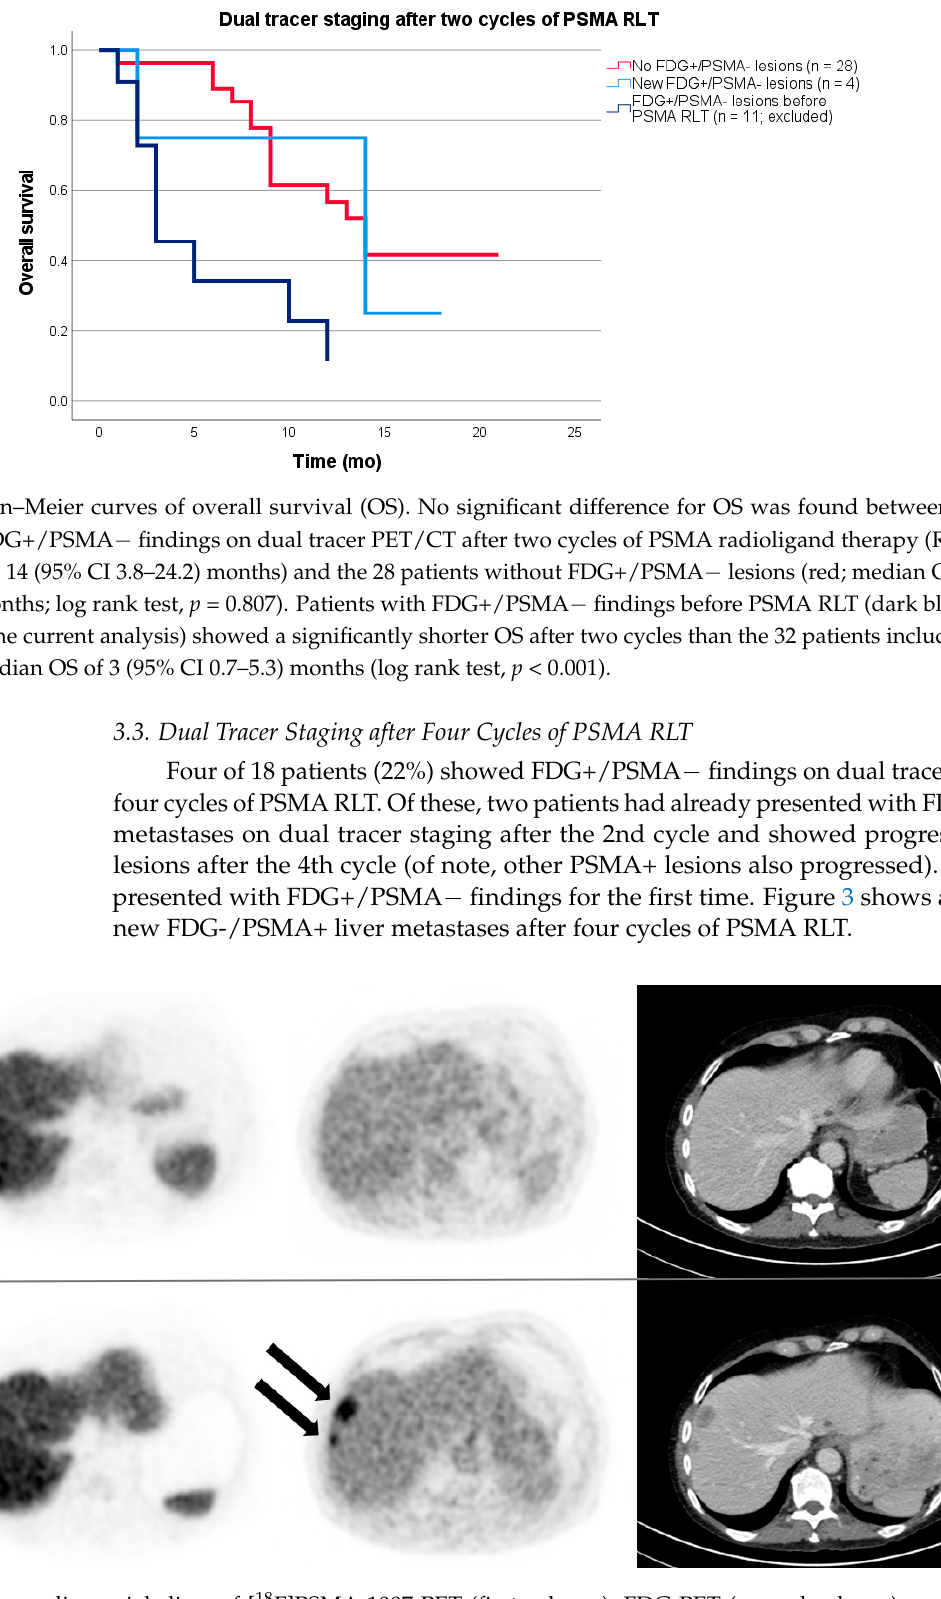
Figure 3. Corresponding axial slices of [ 18 F]PSMA-1007 PET (first column), FDG PET (second column), and contrast enhanced CT (third column) of a 69-year old patient before PSMA radioligandtherapy ( a ) and after four cycles of PSMA radioligandtherapy with new FDG+/PSMA − liver metastases (black arrows); ( b ) fixed inverse gray-scale are displayed with SUV window setting from 0 to 20 ([ 18 F]PSMA-1007 PET) and 0 to 5 (FDG PET),